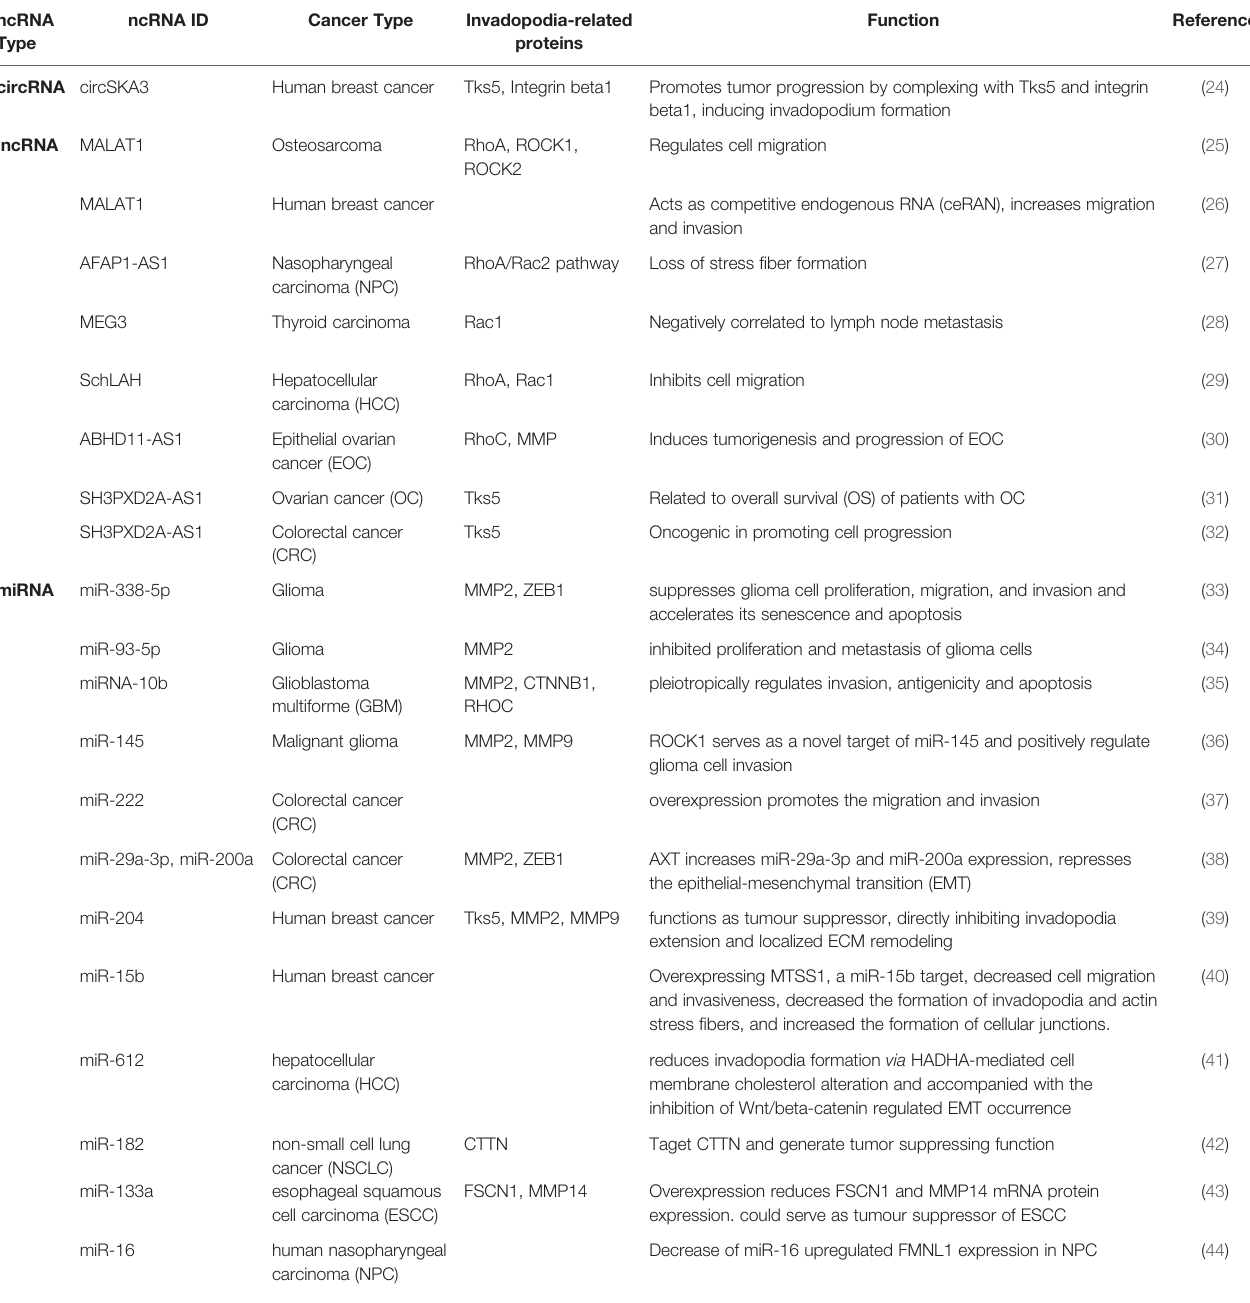
TABLE 1 | ncRNAs examples in invadopodia formation related cancer metastasis